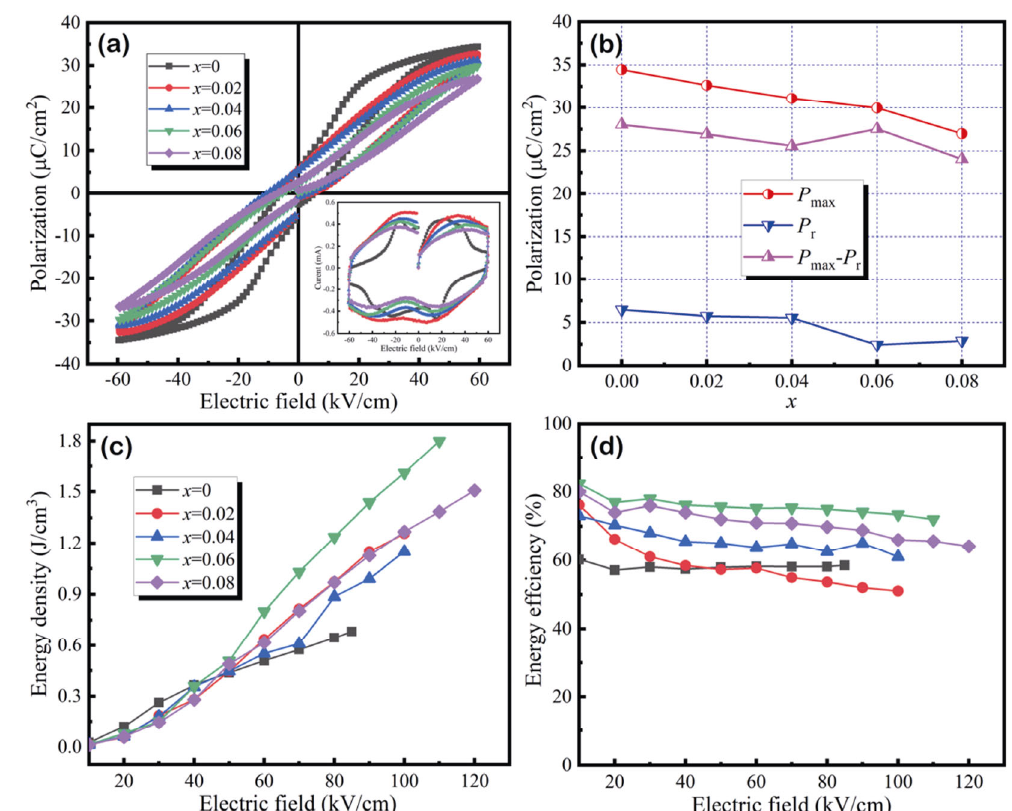
Fig. 6 (a) Measurement of P – E loops at 60 kV/cm for BNS 0.245 − 1.5 x (cid:0) 0.5 x B 0.325+ x T ceramics with different x values, and corresponding I – E loops are shown in the inset; (b) P max , P r , and P max − P r versus x value for BNS 0.245 − 1.5 x (cid:0) 0.5 x B 0.325+ x T ceramics at 60 kV/cm; (c) recoverable energy density W rec and (d) energy efficiency  as a function of applied electric field for BNS 0.245 − 1.5 x (cid:0) 0.5 x B 0.325+ x T